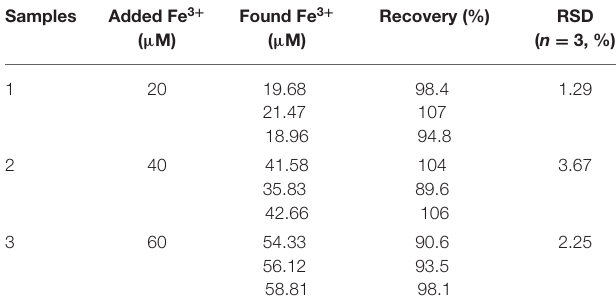
TABLE 1 | Results for the detection of Fe 3 + in tap water. Samples